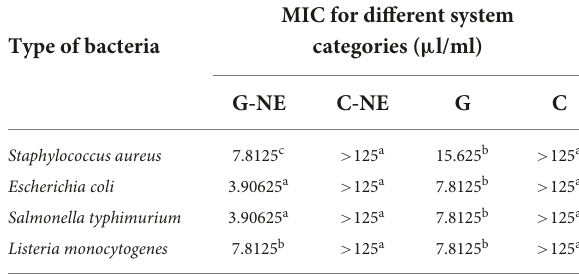
TABLE 4 Inhibition effect of different treatments on the four model bacteria. Type of Diameter of BIC of different bacteria